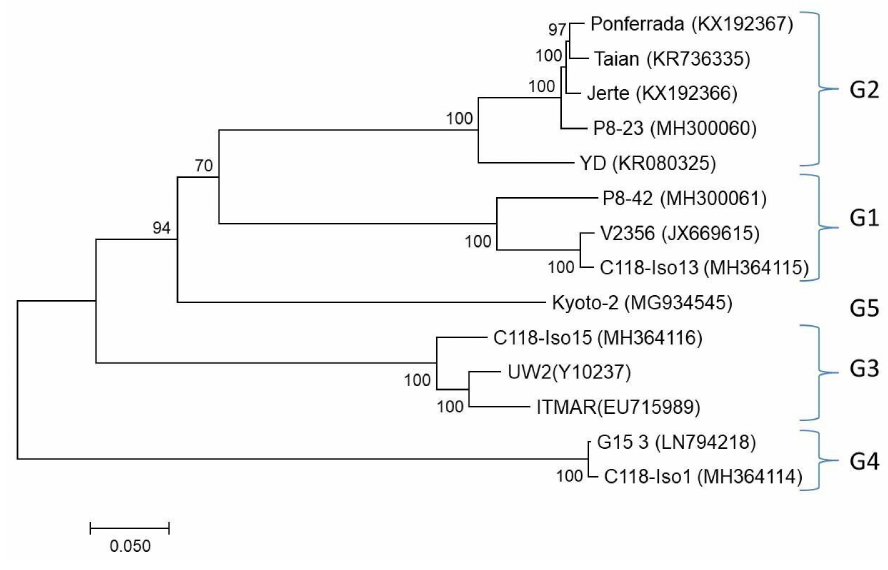
Figure 4. Maximum likelihood phylogenetic tree inferred from the complete nucleotide sequences of LChV1 isolates. All isolates are reported with their names followed by their accession numbers. The tree is midpoint-rooted. The numbers above or below each branch are the nonparametric bootstrap (NPB) values given as percentages of 500 replicates. Only NPB values with p > 70 are shown.